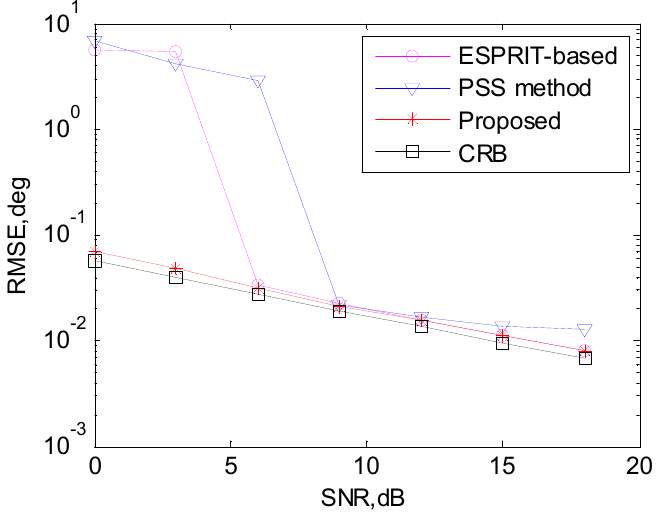
Figure 5. DOA estimation performance comparison with closely-spaced sources.